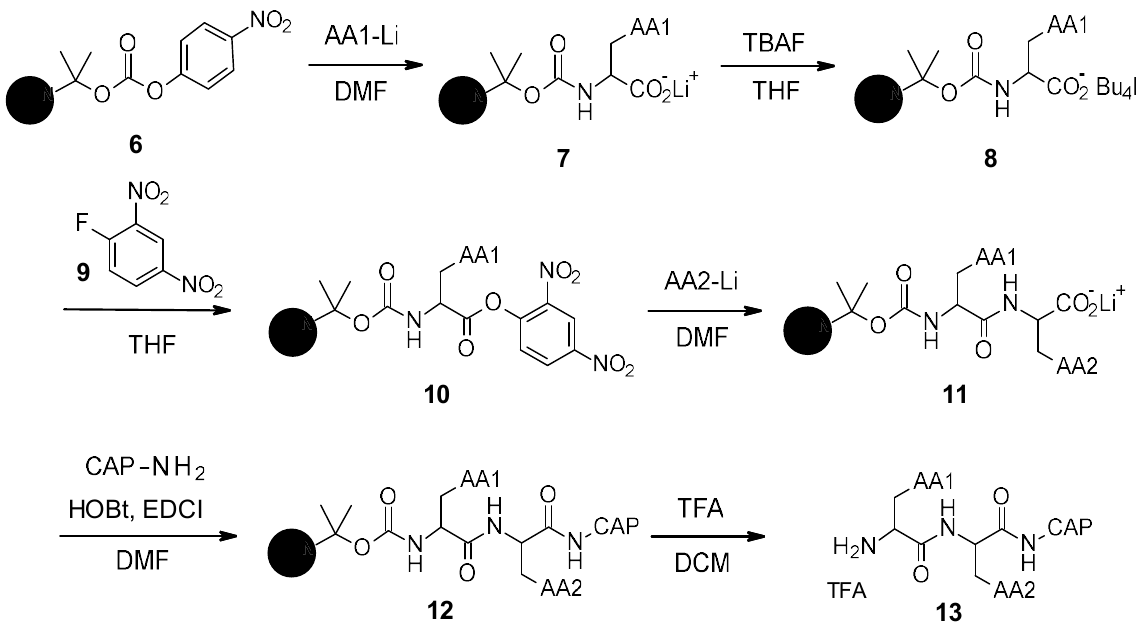
Figure 2. Structure of PA βN analogues.